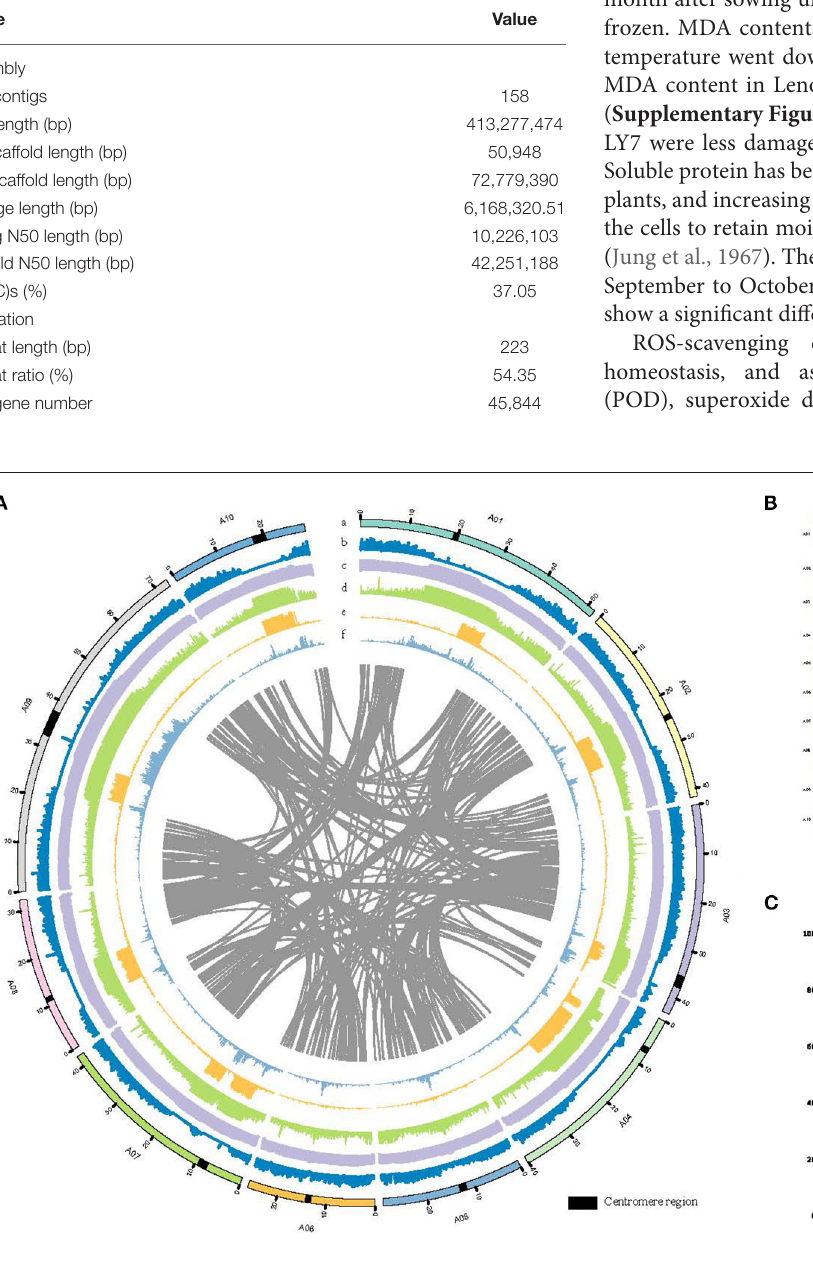
Frontiers in Plant Science |